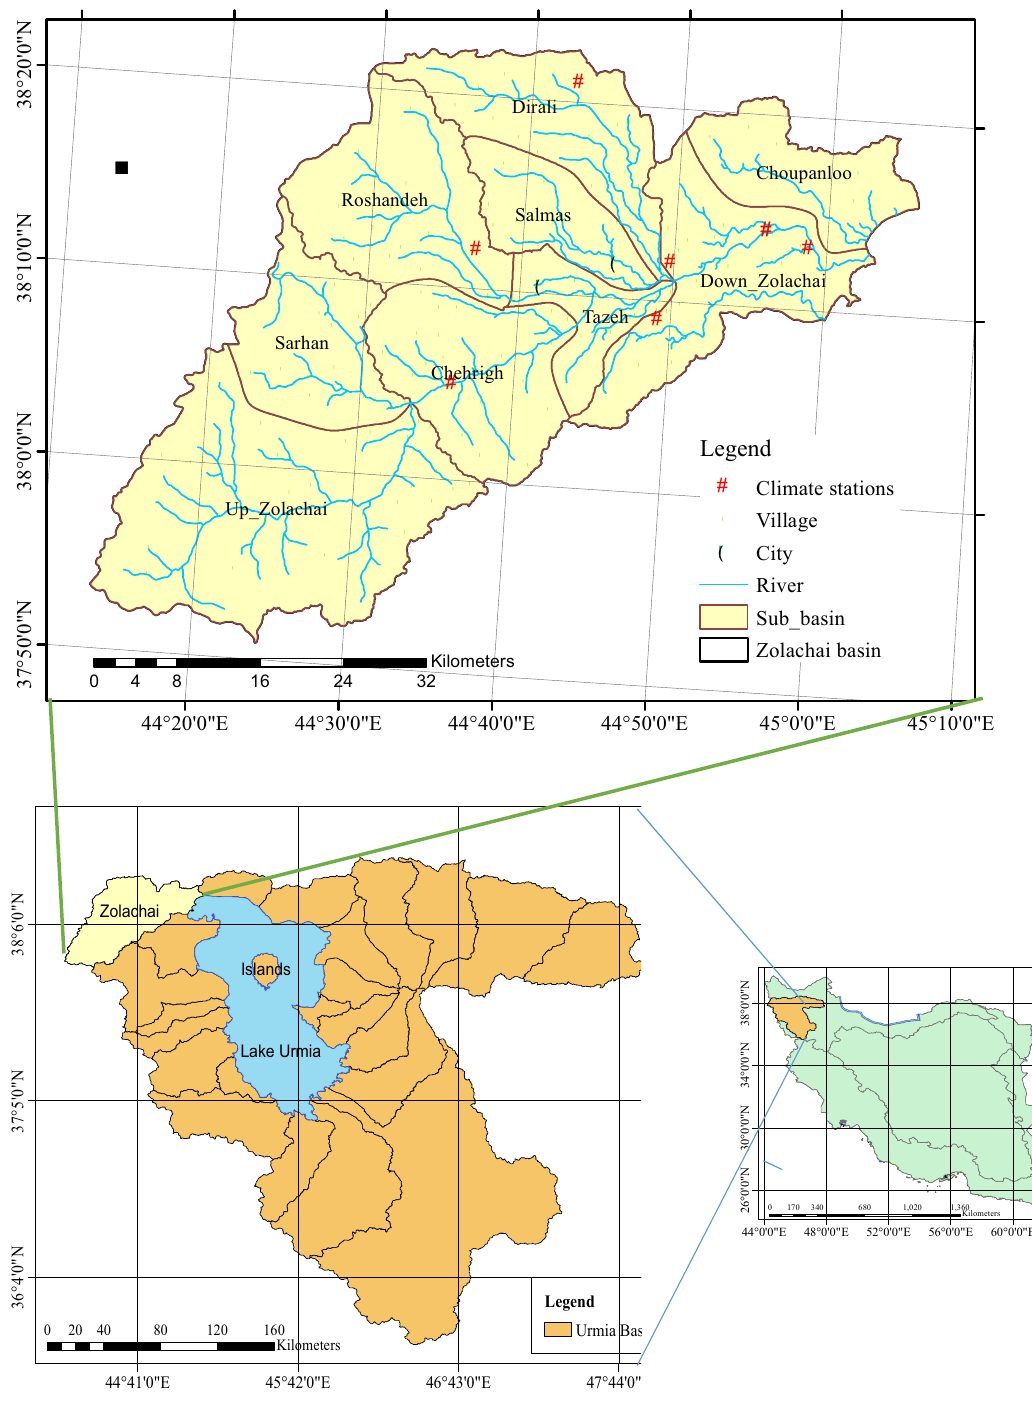
Figure 1. Location of Zolachai basin in ULB and